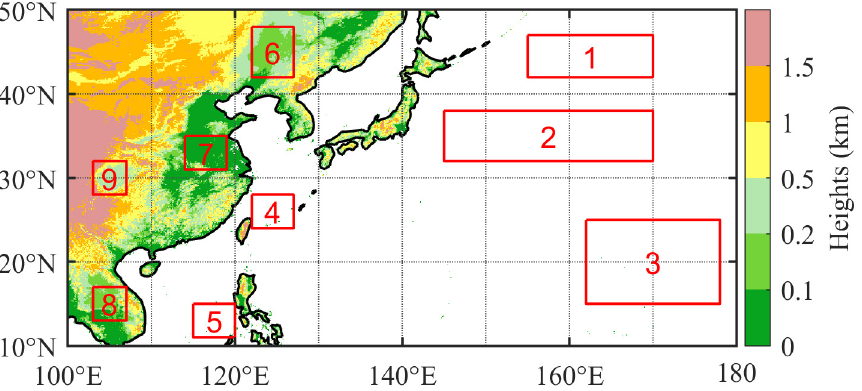
Table 1. Latitudinal and longitudinal ranges of the nine regions of interest.